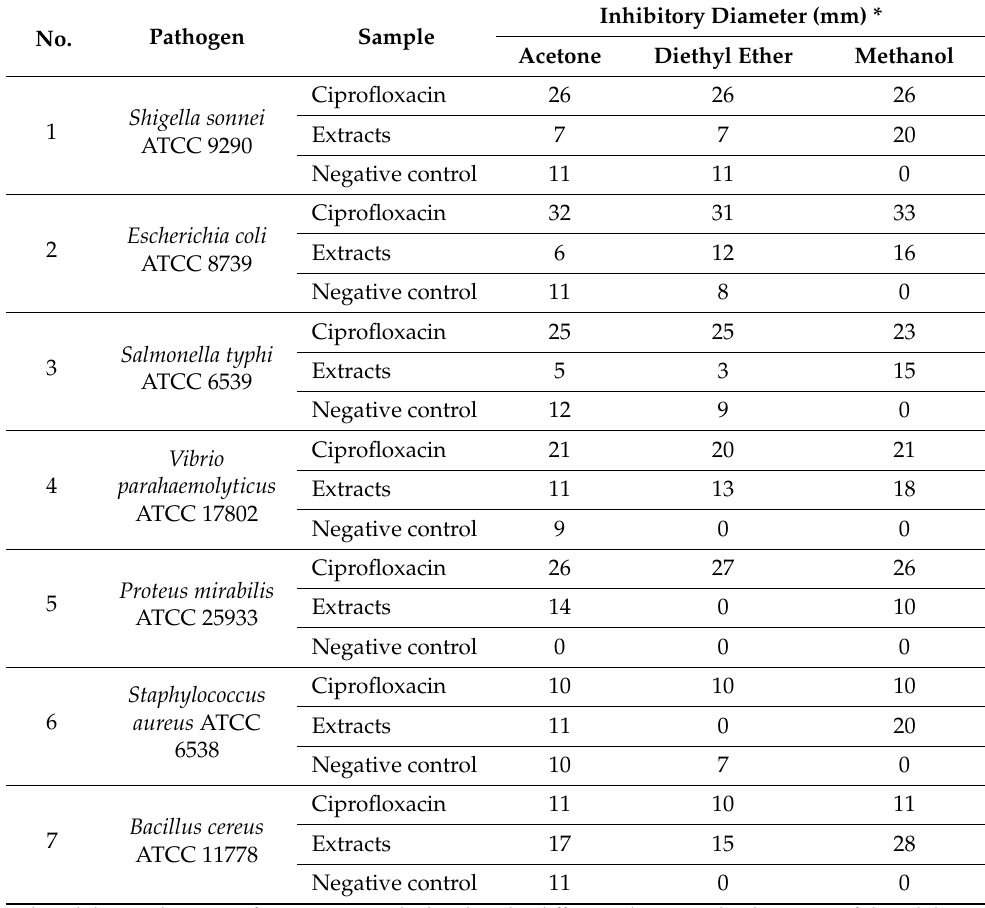
Table 2. Antibacterial activities of avocado extracts using different solvents against seven pathogens as presented in the diameters of inhibition zones using an agar well diffusion